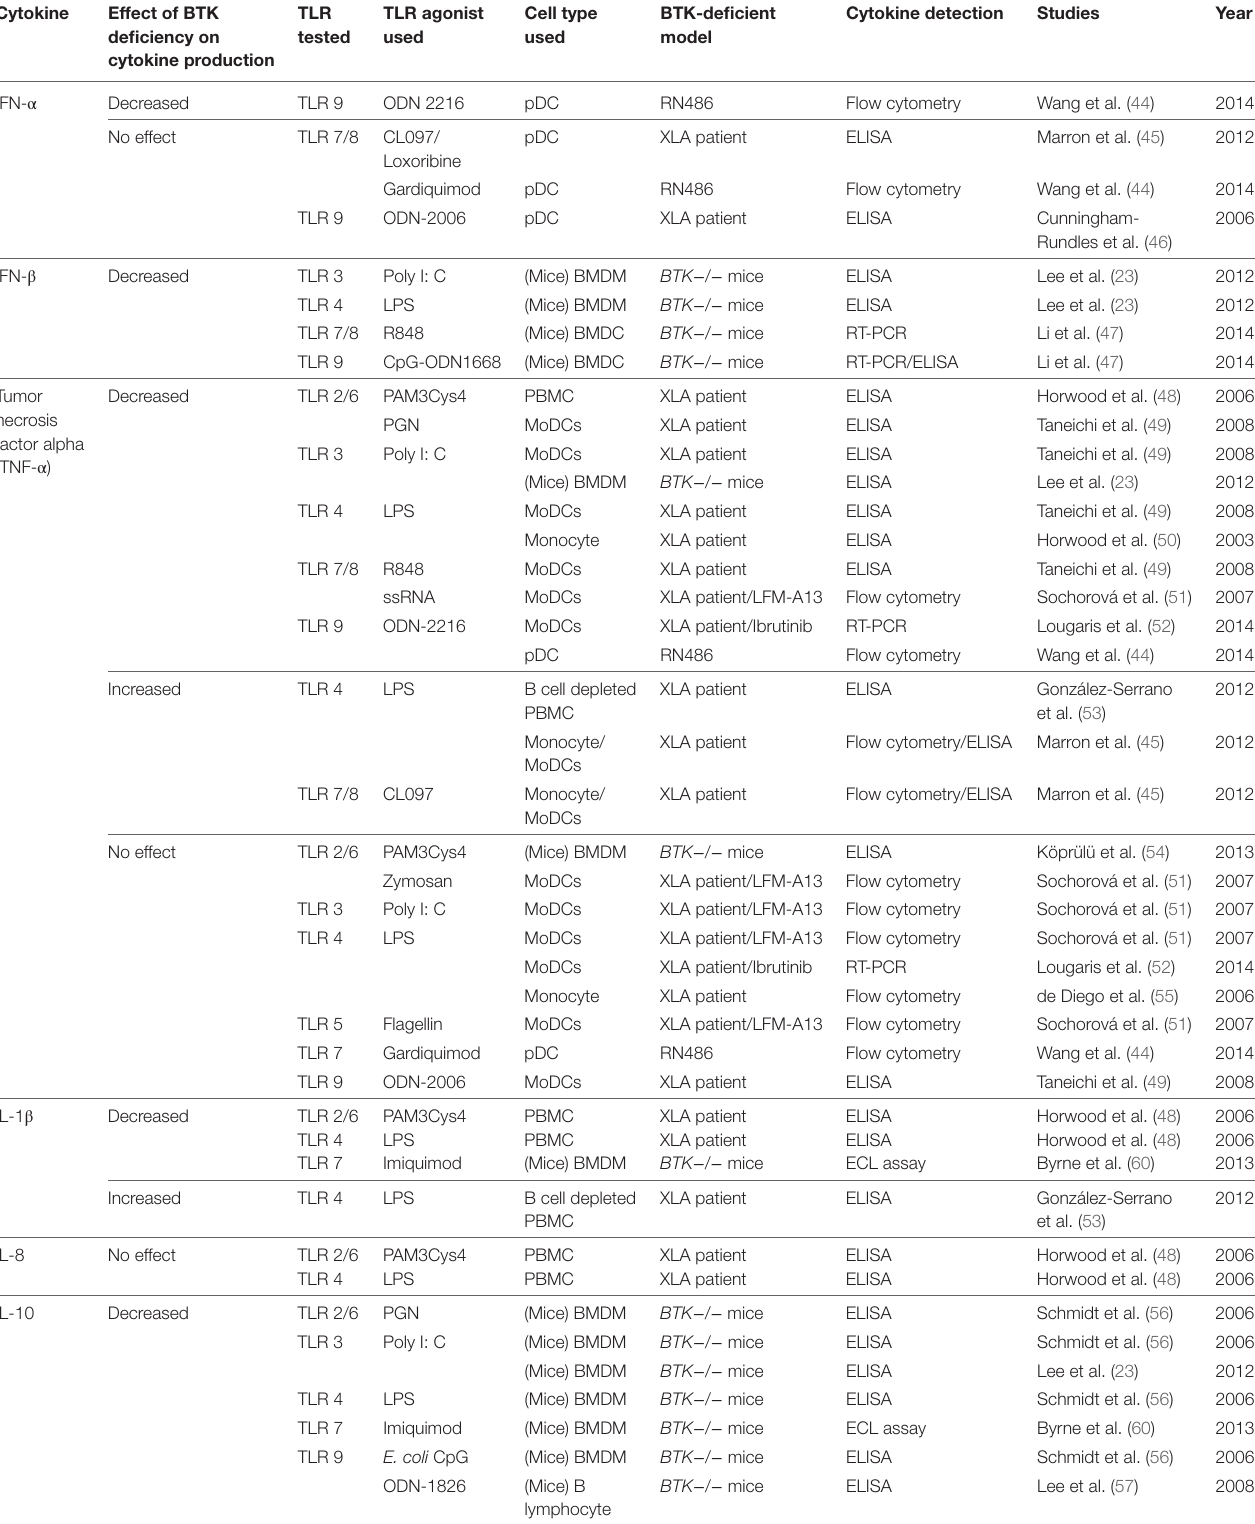
TaBle 2 | Previous studies on the effect of BTK deficiency on cytokine productions in response to TLR agonists. cytokine effect of BTK deficiency on